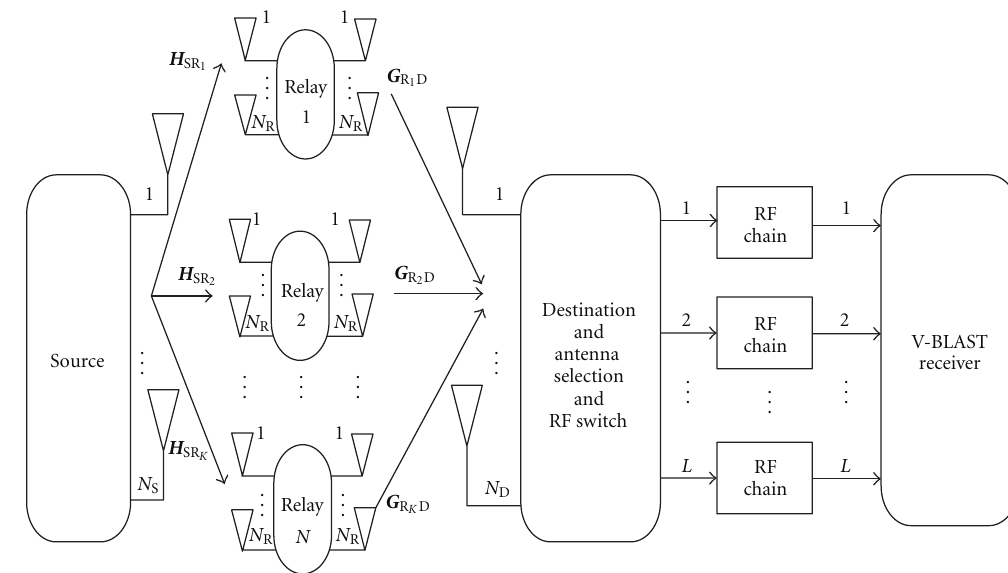
Figure 1: Block diagram of an AF-approach MIMO multiple-relay system in which the source node, each of N half-duplex AF-relay nodes, and the destination node are equipped with N S , N R , and N D antennas,